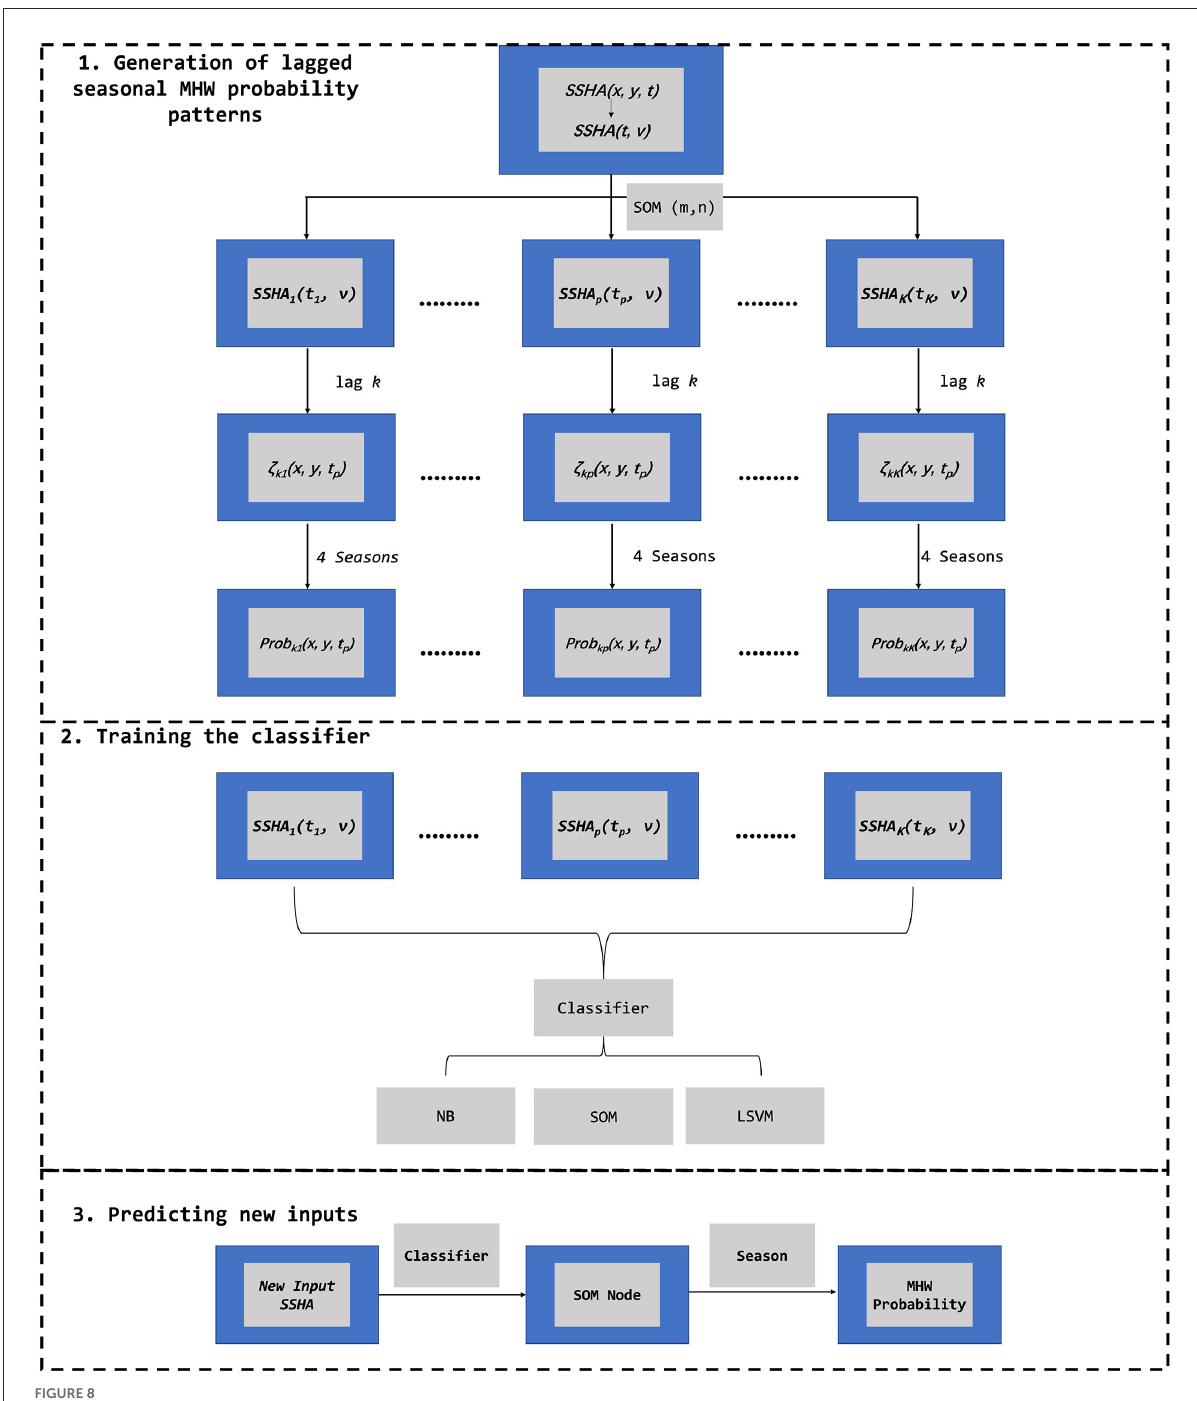
FIGURE8 The architecture of the model. (1) SSHA are used to train the SOM, clustering each time point into a particular node. With a lag k days, the probability of MHW existence in a particular spatiotemporal grid is determined using the proportion of MHW exposures in each season for a particular SOM node. (2) A classifier (SOM/Naïve Bayes/Linear Support Vector Machine) is trained taking SSHA as inputs to (3) label new input SSHA into a particular SOM node, and the existence of MHW is determined if its corresponding probability is above the threshold determined by F –